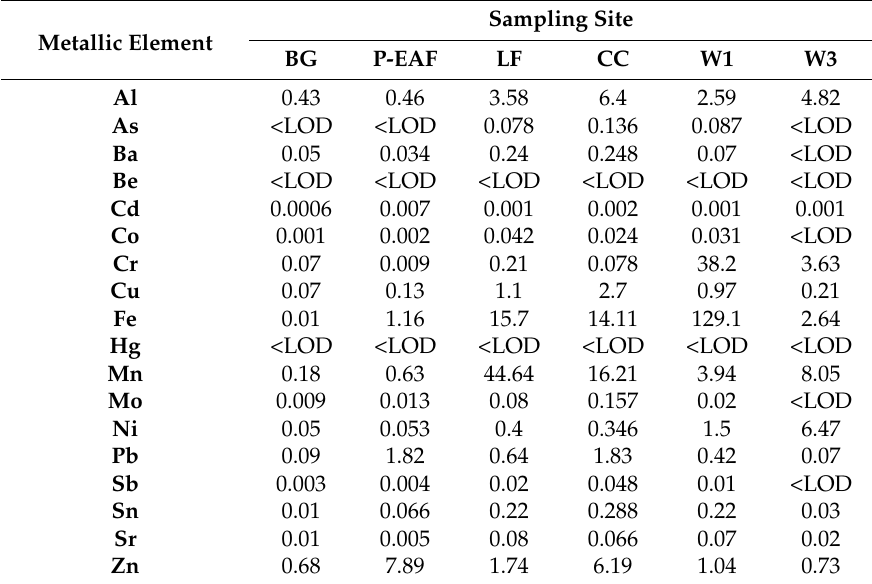
Table 4. Concentration in µ g/m 3 of the metallic elements determined in the inhalable fraction. Metallic